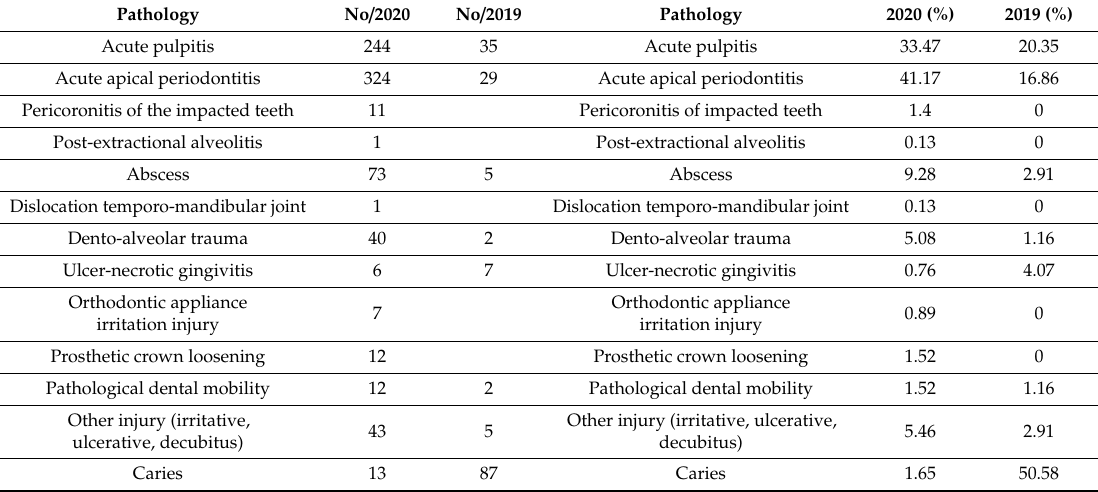
Table 1. Distribution of disease type and diagnosis in the emergency department during April 2019